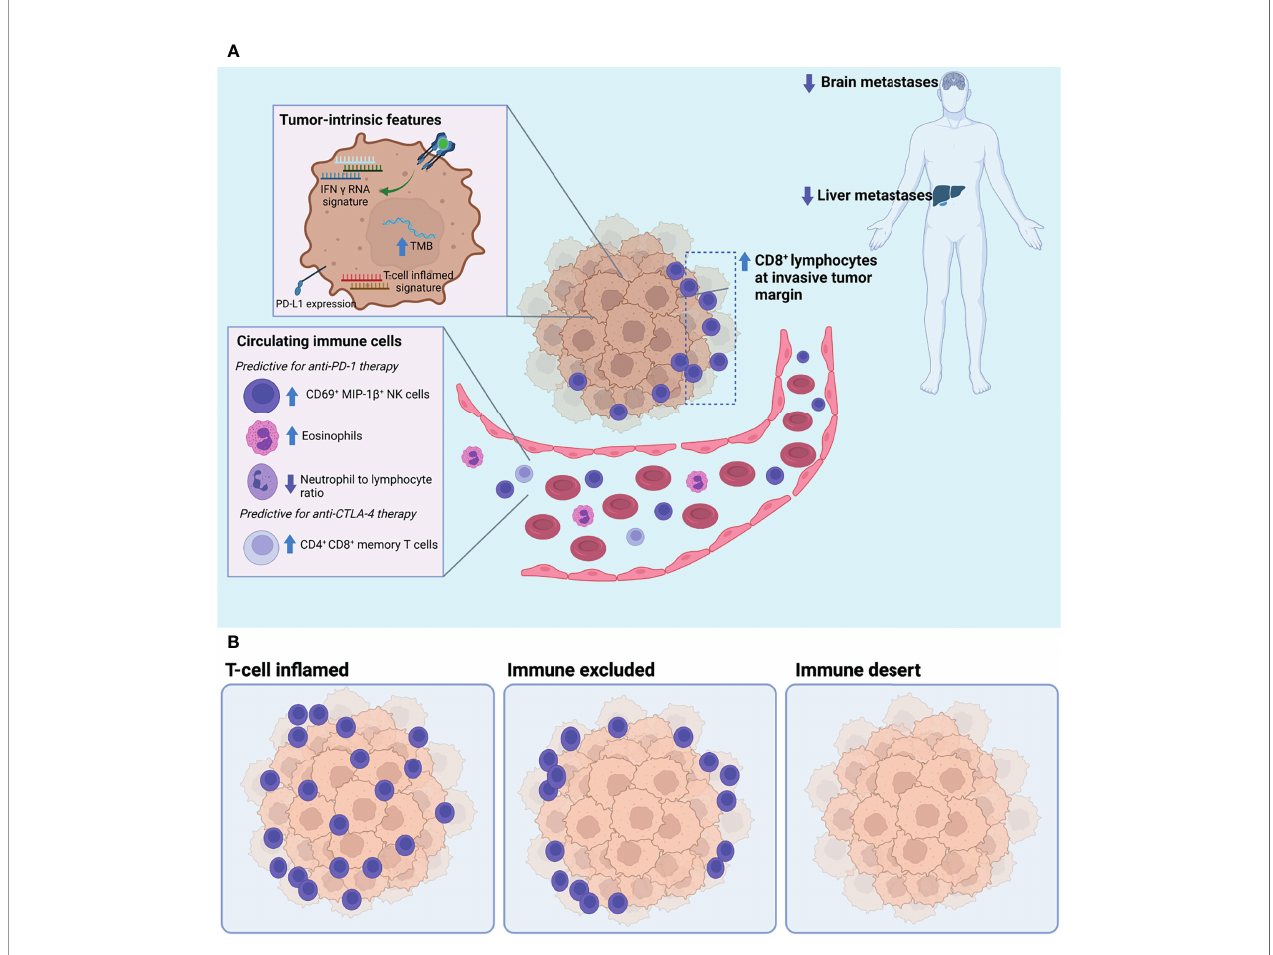
FIGURE 1 | (A) Tumor-intrinsic and circulating biomarkers associated with response to immune checkpoint blockade. (B) Three archetypical tumor microenvironments de fi ned by the degree of T cell in fi ltration: T cell in fl amed, immune excluded, and immune desert. Of these, the T cell-in fl amed phenotype has been positively associated with response to immune checkpoint blockade. TMB, tumor mutational